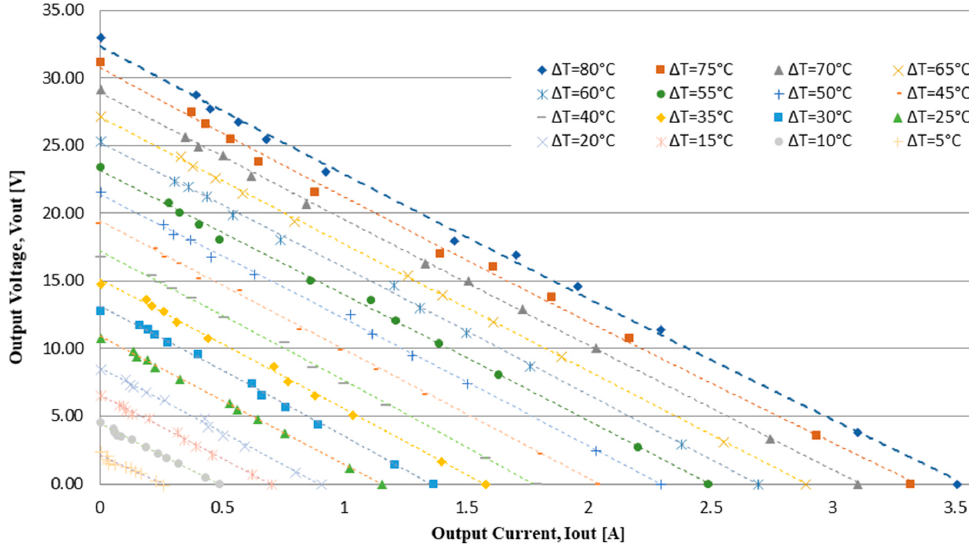
Figure 3. Output voltage vs. output current curve.